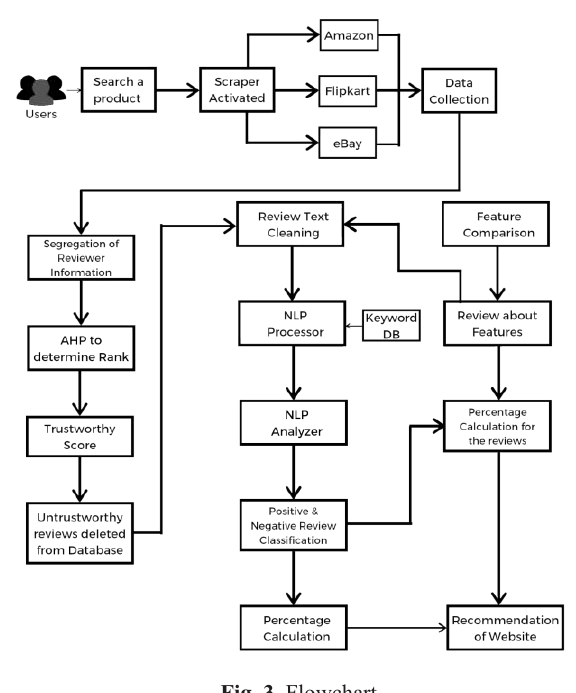
Fig. 3. Flowchart